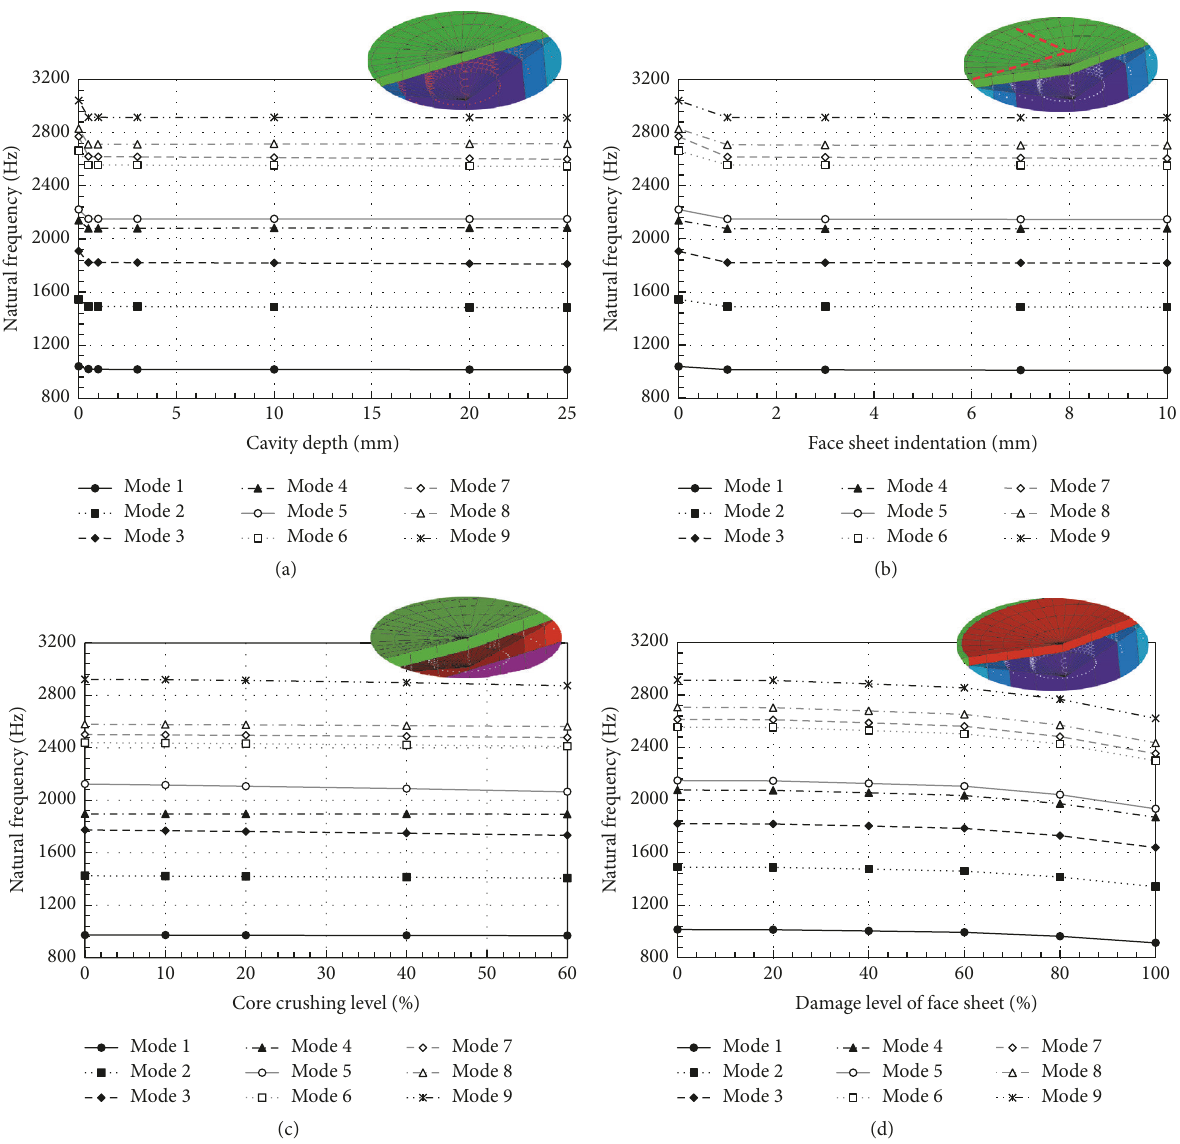
Figure 14: The influence of the key parameters of the impacted zone on the natural frequencies